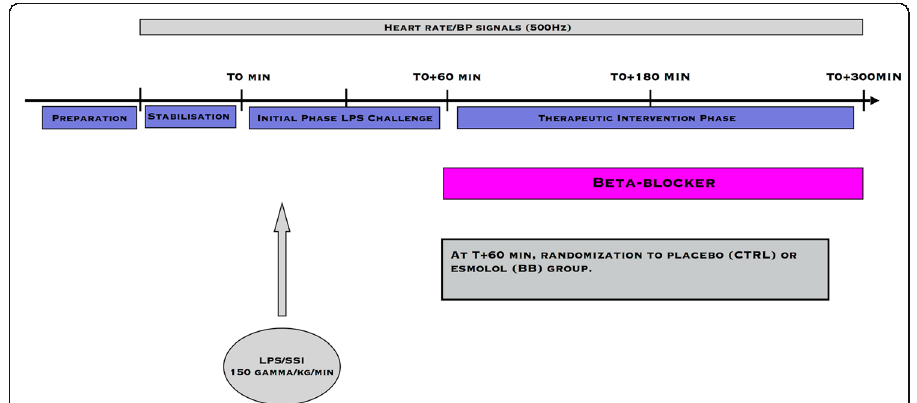
Fig. 1 Study design. After a short period of stabilization, endotoxin was injected continuously during 30 min. Thirty minutes after the end of the LPS infusion beta-blocker was started